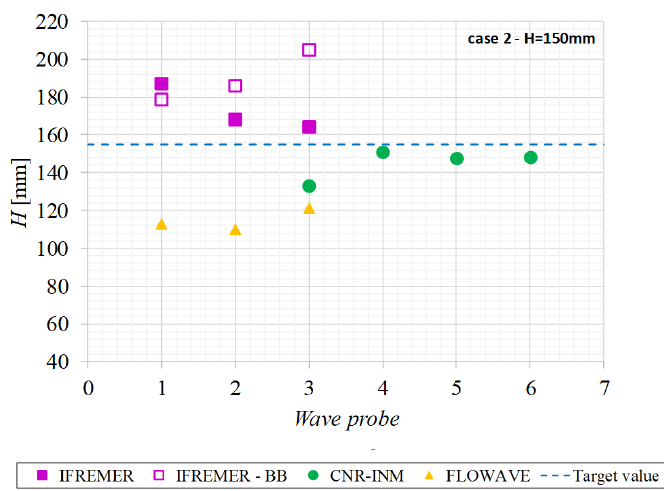
Figure 13. Wave height H comparison between the different wave probes at each facility for case 2. I FREMER -BB are the bare-basin, flow characterisation tests. Dashed line represents the target wave height for case 2 of H = 150 mm. For the physical location of each wave probe, refer to Figure